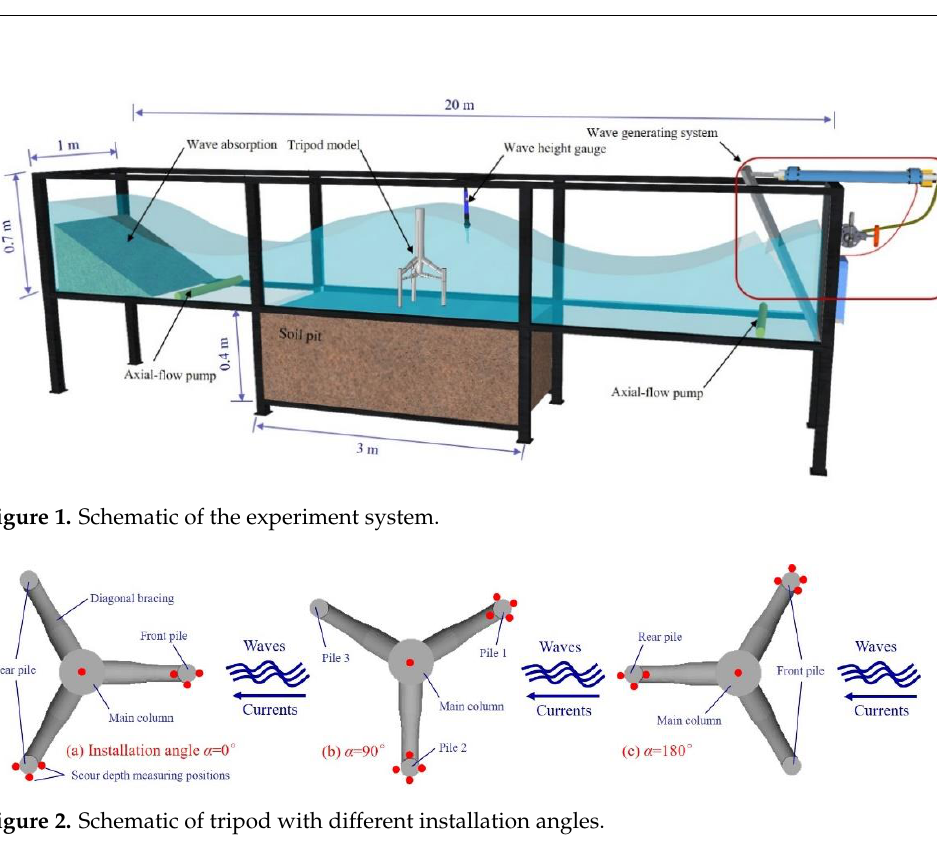
Figure 2. Schematic of tripod with different installation angles.